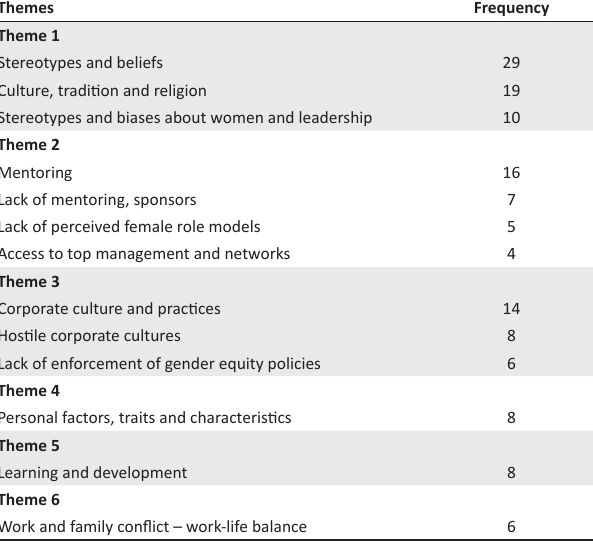
TABLE 2: Themes that emerged from the